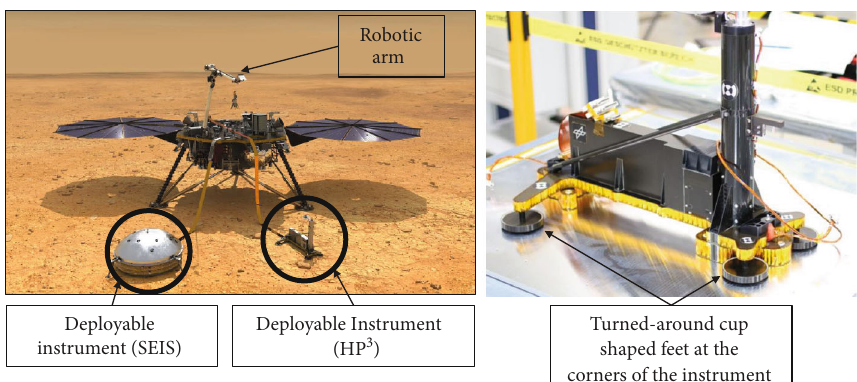
Figure 1: Left: artist ’ s illustration of the InSight lander on the surface of Mars (Image Credit: NASA/JPL [6]). Right: the HP 3 instrument fl ight-model in DLR cleanroom